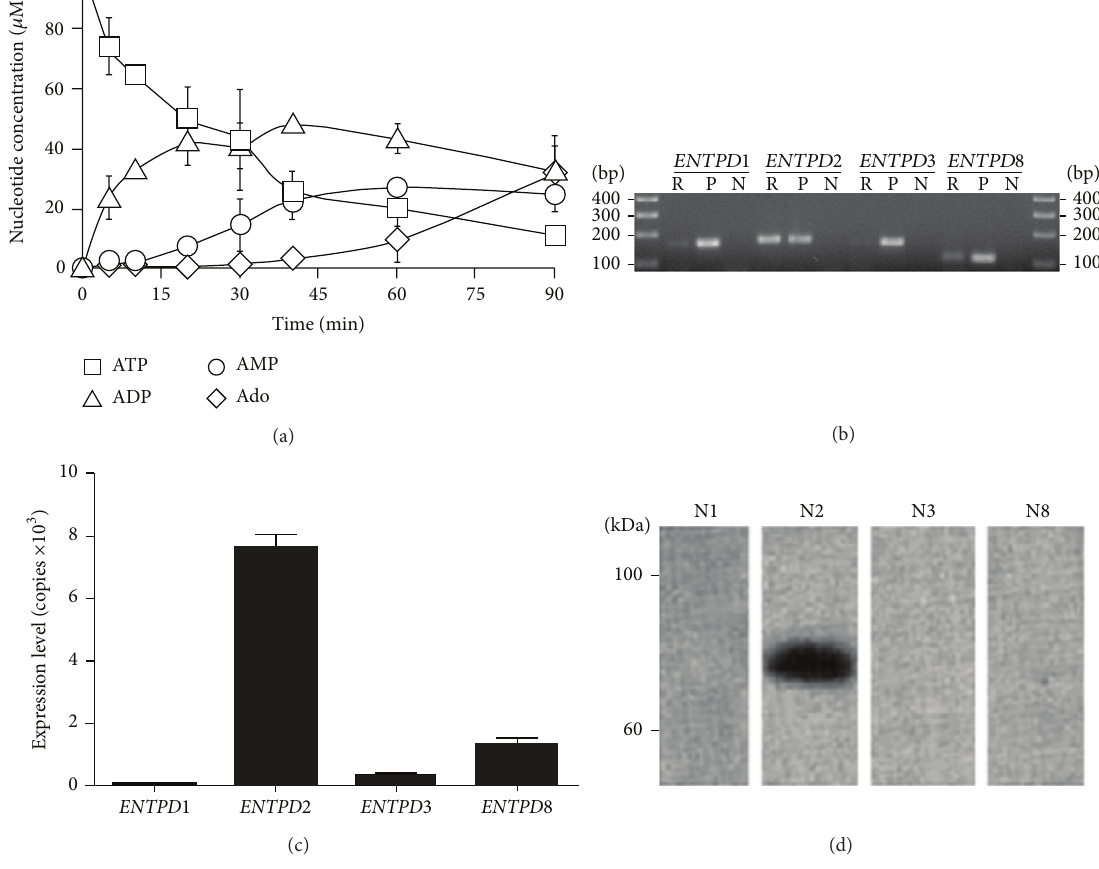
Figure 1: NTPDase2 is expressed by HT-29 cells. (a) HT-29 cells were incubated with ATP for 90 min and their supernatants were then subjected to RP-HPLC to quantify the various ATP degradation products ( 𝑛 = 3 ). (b) The expression of various human NTPDase genes was analyzed by semiquantitative RT-PCR where R, P, and N represent the reaction with HT-29 cells, the positive controls, and the negative controls, respectively, and (c) by quantitative RT-PCR ( 𝑛 = 5 ). (d) The expression of NTPDase proteins in HT-29 cells was analyzed by immunoblotting using specific antibodies to human NTPDase1, -2, -3, and -8, N1, N2, N3, and N8, respectively. A representative experiment of 𝑛 = 4 is shown.